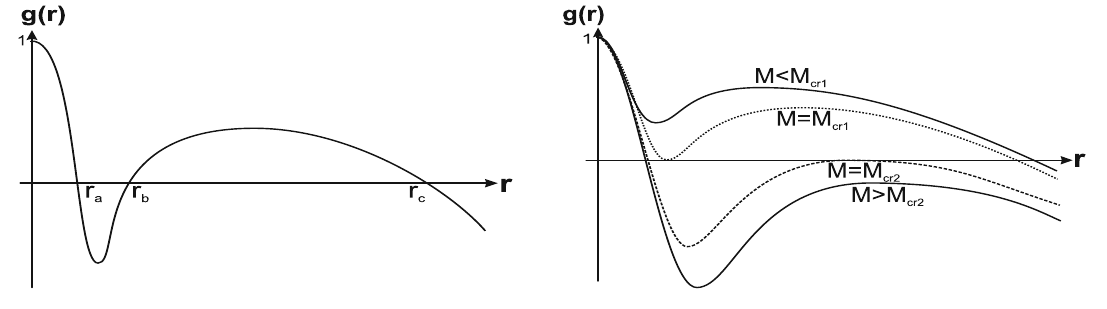
Figure 1. Typical behavior of the metric function g ( r ) for the case of two vacuum scales.